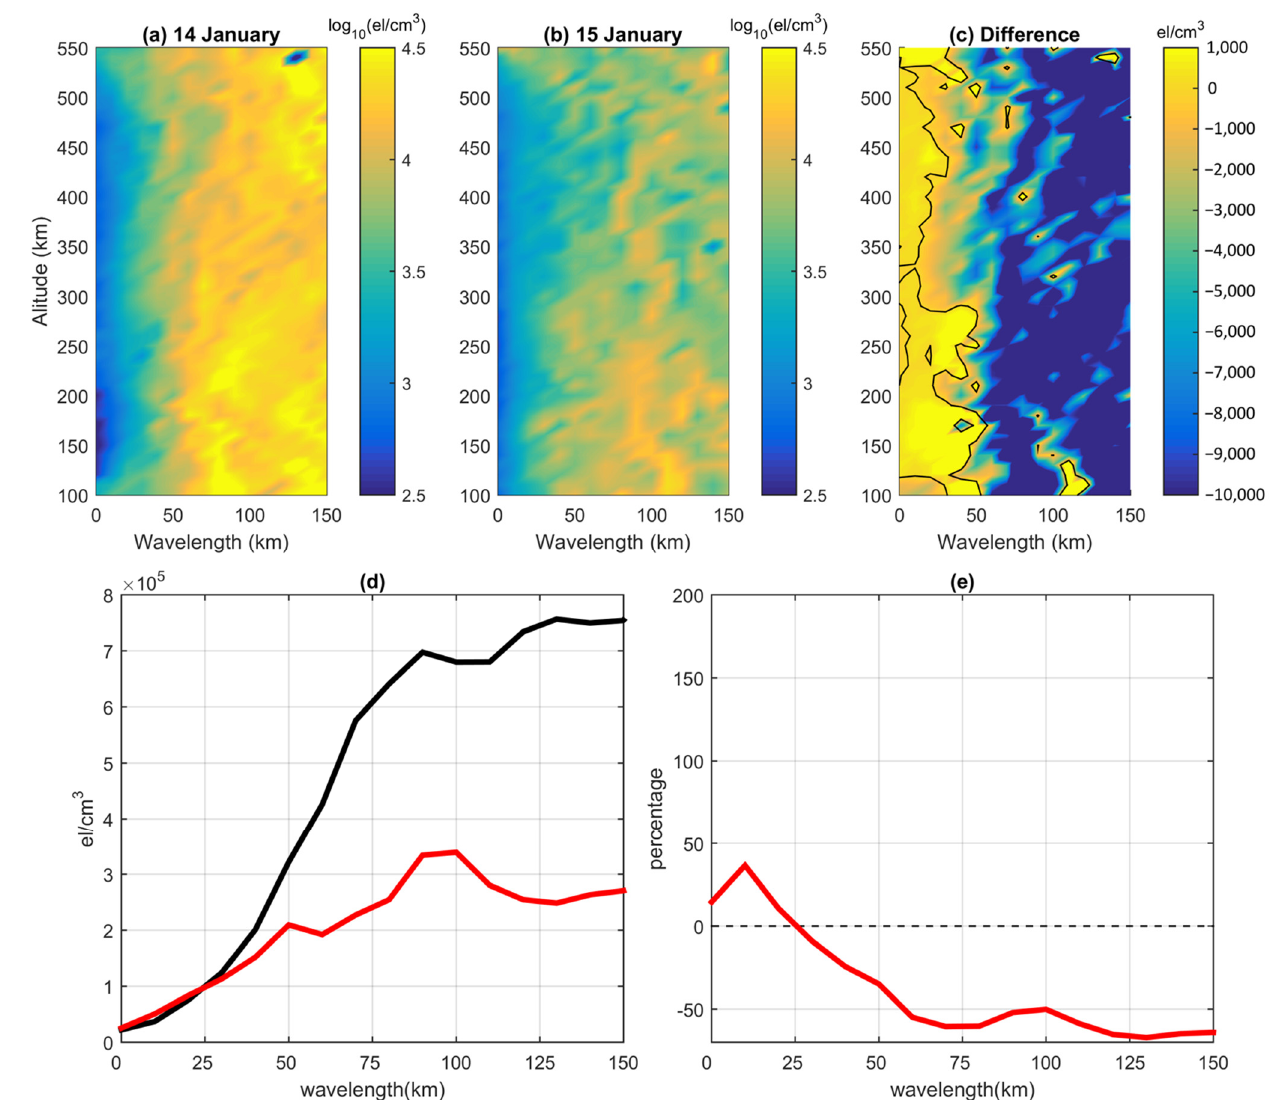
Figure 5. Hilbert spectra of Ne profiles from 10:00 UT to 16:00 UT on ( a ) 14 and ( b ) 15 January (eruption day). ( c ) Difference between the spectra on the eruption day and one day before. The contour line sketched the value of 0 el/cm 3 . ( d ) The black and red curves are the marginal spectra on 14 ( 𝑛 (cid:3041)(cid:3042)(cid:3045)(cid:3040)(cid:3028)(cid:3039) ) and 15 January ( 𝑛 (cid:3032)(cid:3045)(cid:3048)(cid:3043)(cid:3047)(cid:3036)(cid:3042)(cid:3041) ), respectively. ( e ) Relative difference between the marginal spectra that is defined as (cid:4666)𝑛 (cid:3032)(cid:3045)(cid:3048)(cid:3043)(cid:3047)(cid:3036)(cid:3042)(cid:3041) (cid:3398) 𝑛 (cid:3041)(cid:3042)(cid:3045)(cid:3040)(cid:3028)(cid:3039) (cid:4667) / 𝑛 (cid:3041)(cid:3042)(cid:3045)(cid:3040)(cid:3028)(cid:3039) .